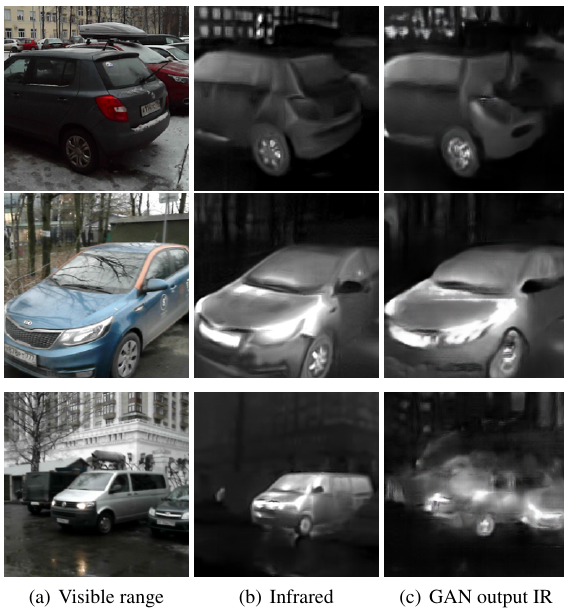
Figure 6. Examples of generated images